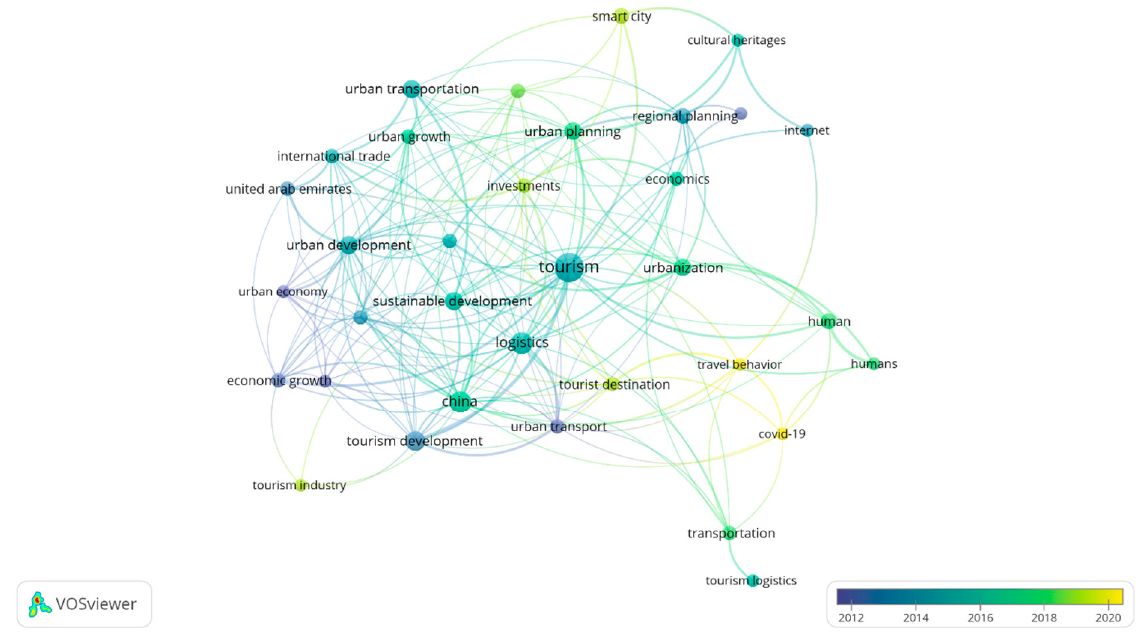
Figure 4. Map of links between the analysed keywords, broken down by the mean year of publication release. Source: Own elaboration using the VOSviewer software.